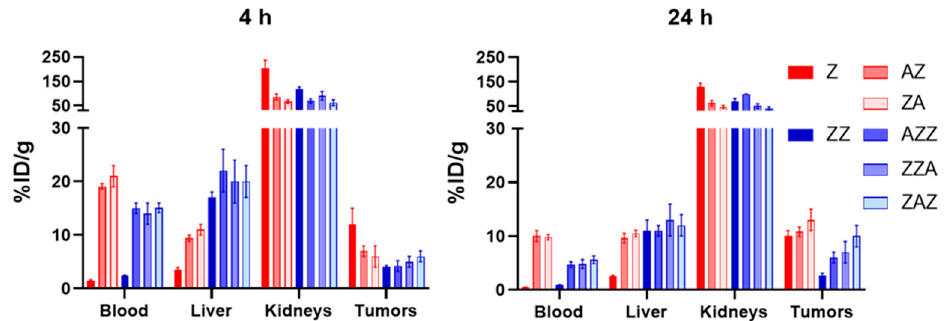
Figure 3. Biodistribution of HER2-targeting conjugates labeled with technetium-99m in mice bearing HER2-positive SKOV-3 xenografts. Data are presented as an average value from the selected organs and tumor ± 1 SD, n = 4.